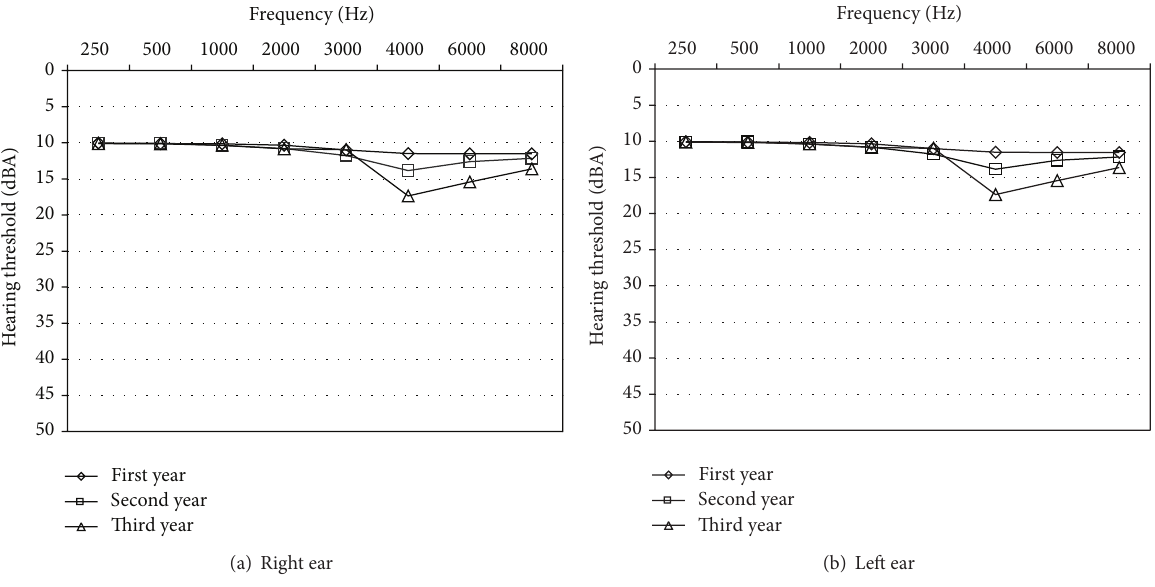
Figure 1: Trend of hearing threshold change in right and left ears in different years of evaluation among all